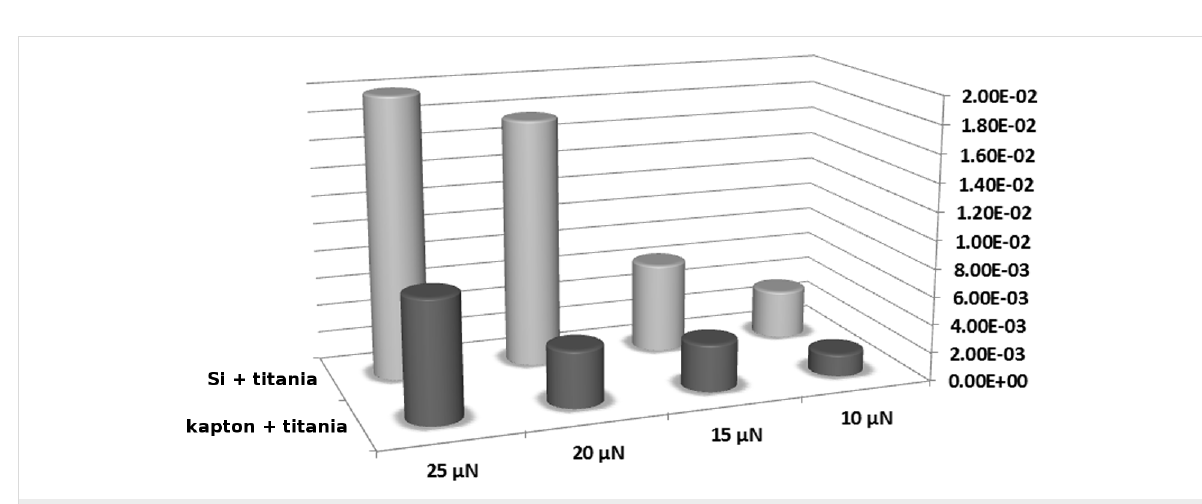
Figure 4: Wear volumes (in µm 3 ) resulting from different loads for the titania coatings on Si and kapton.